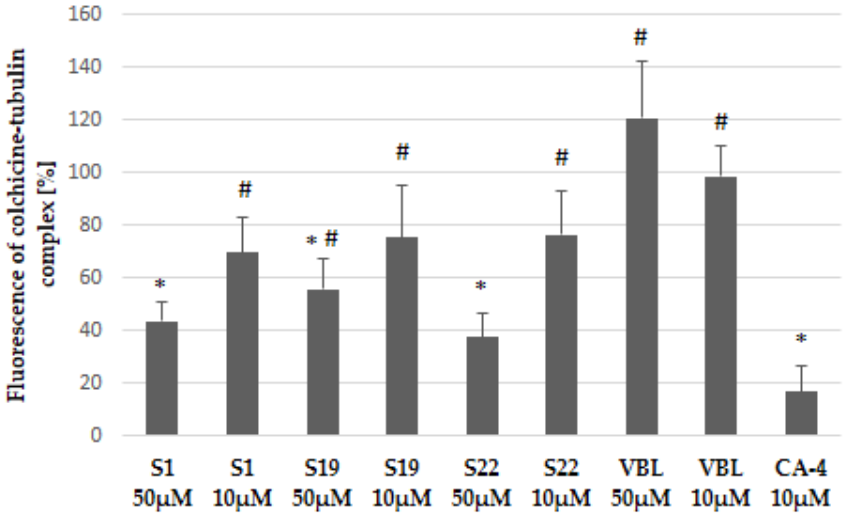
Figure 9. Colchicine competitive binding assay. Results have been shown as intrinsic fluorescence of colchicine-tubulin complex normalized to control (0.2% DMSO). CA-4 was used as a positive control whereas vinblastine (VBL), which binds at vinblastine site, was used as negative control. Data are expressed as the mean and SD from three independent experiments for S1 , S19 , S22 , CA-4 and two independent experiments for VBL; * p < 0.05 vs. ctrl; # p < 0.05 vs. CA-4.